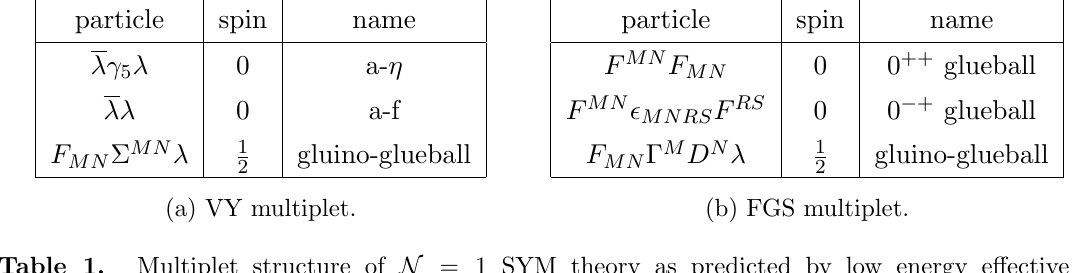
Multiplet structure of N = 1 SYM theory as predicted by low energy e(cid:11)ective actions [4,